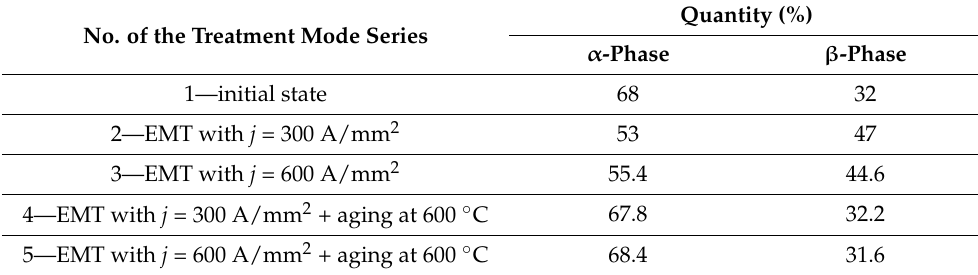
Table 2. Results of semi-quantitative phase